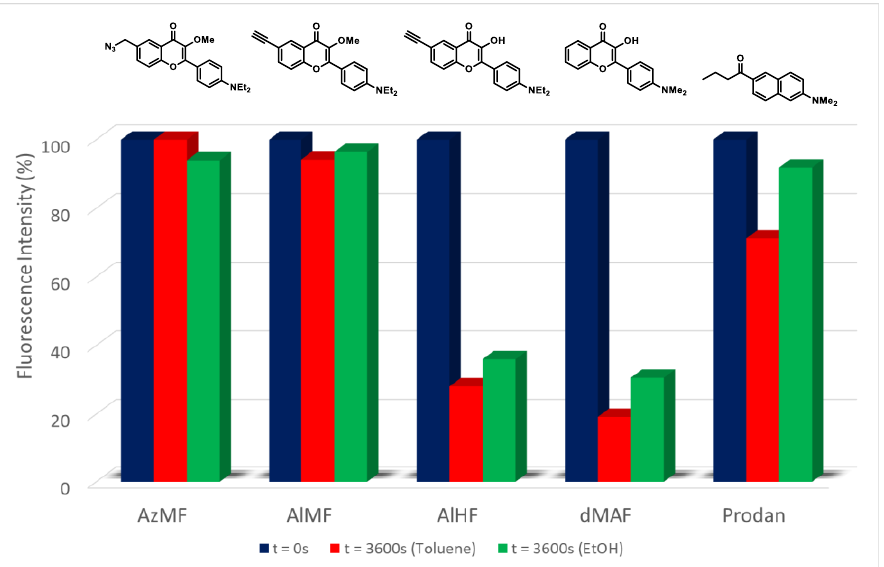
Figure 4. Photobleaching evolution of AzMF , AlMF , AlHF , and push – pull references dMAF and Prodan over the course of a one-hour experiment in toluene and EtOH.